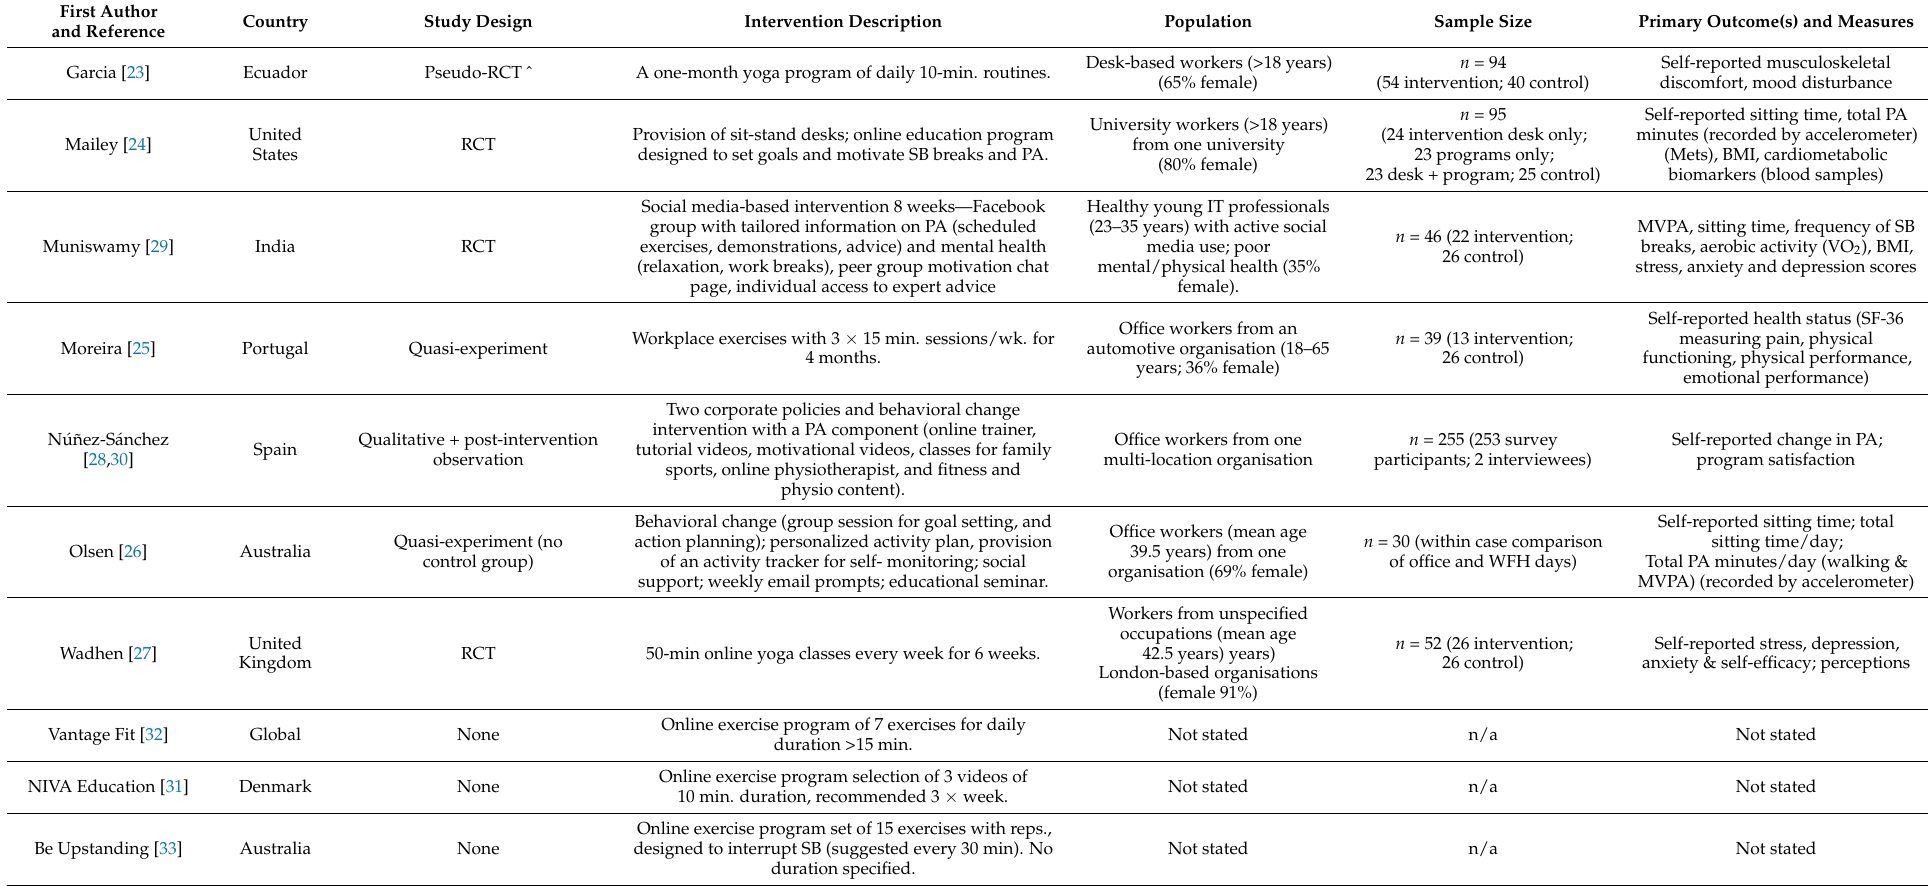
Table 2. Summary of included